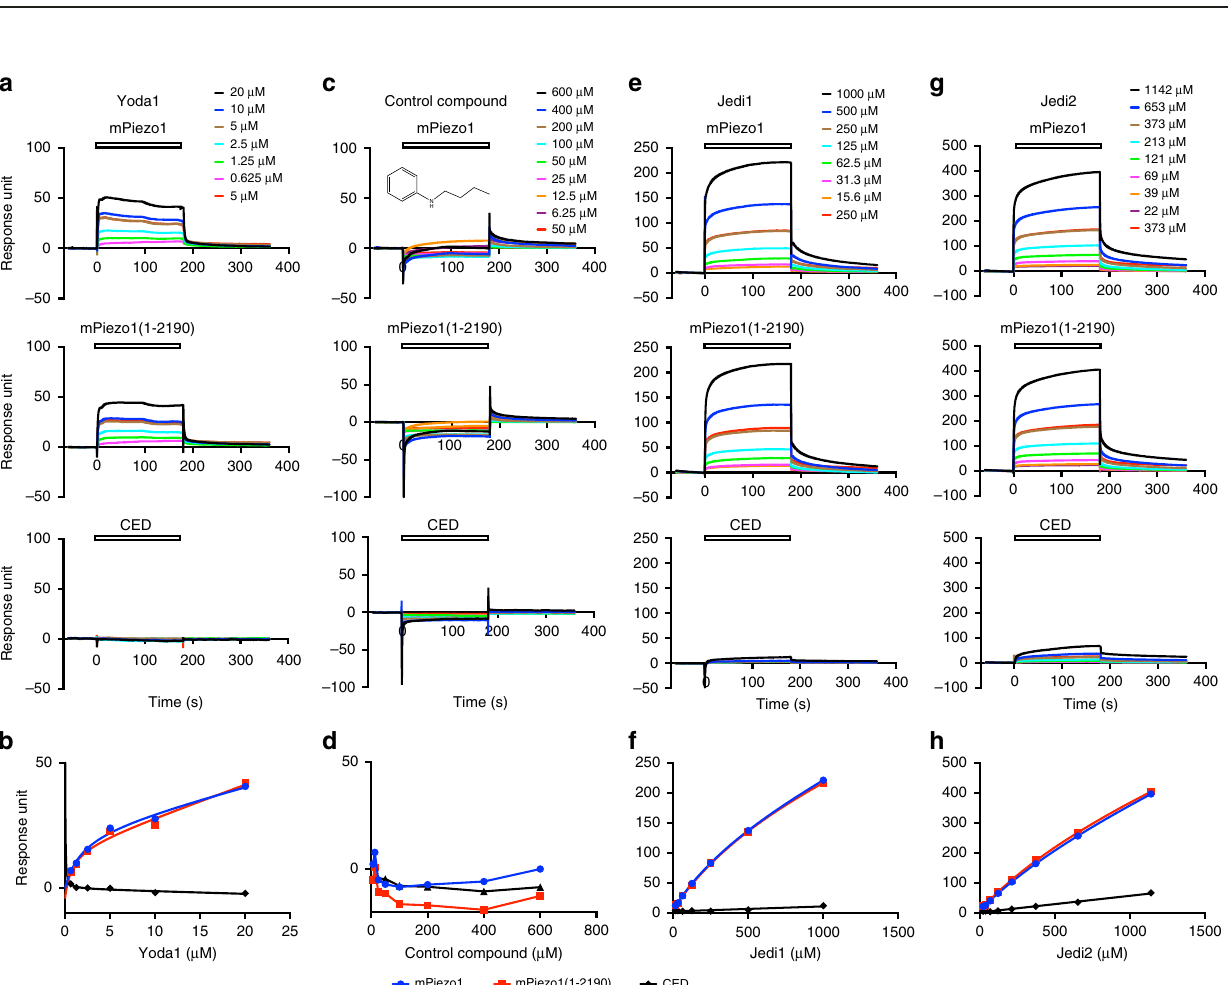
Fig. 3 Electrophysiological effects of Jedi1 and Yoda1 on Piezo1. a Representative whole-cell current traces in response to either 1 mM Jedi1 or 30 μ M Yoda1, which was puffed onto the recorded cells. The red arrows indicate the onset of the current. b , c Scatter plot of the current amplitudes ( b ) or onset ( c ) induced by the compound. Statistical signi fi cance was assessed using the unpaired Student ’ s t -test. d Representative channel activities of mPiezo1- expressing cells in the inside-out patch con fi guration at − 80 mV. The compounds were in the pipette solution. e , f Scatter plot of the NP o ( e ) or unitary conductance ( f ). Statistical signi fi cance was assessed using one-way ANOVA with Dunn ’ s comparison to DMSO. g Representative stretch-activated currents at − 80 mV from mPiezo1-expressing cells. The red traces show the single-channel activities in the absence of externally applied force (Supplementary Fig. 1d). h Pressure-current relationships fi tted with a Boltzmann equation. i Scatter plot of the P 50 calculated from fi t of the pressure- current relationship of individual recordings with a Boltzmann equation. Statistical signi fi cance was assessed using one-way ANOVA with Dunn ’ s comparison to DMSO. j , m Representative traces of poking-induced inward currents at − 60 mV with the indicated compound present either in the extracellular ( j ) or internal ( m ) recording buffer. k , n Scatter plot of the maximal poking-induced currents. Statistical signi fi cance was assessed using one- way ANOVA with Dunn ’ s comparison to DMSO. l , o Scatter plot of the inactivation Tau of the poking-induced currents. Statistical signi fi cance was assessed using one-way ANOVA with Dunn ’ s comparison to DMSO. p Three consecutive poking-induced current traces that reached the steady state under DMSO, 200 μ M Jedi1, and 200 μ M Jedi1/30 μ M Yoda1, respectively, are shown. q , r Scatter plot of the fold change ( q ) or inactivation tau ( r ) of the poking-induced currents. Statistical signi fi cance was assessed using one-way ANOVA with Tukey ’ s multiple comparisons test. Each bar represents mean ± s.e.m., and the recorded cell number is labeled above the bar. *** P < 0.001, ** P < 0.01, * P <